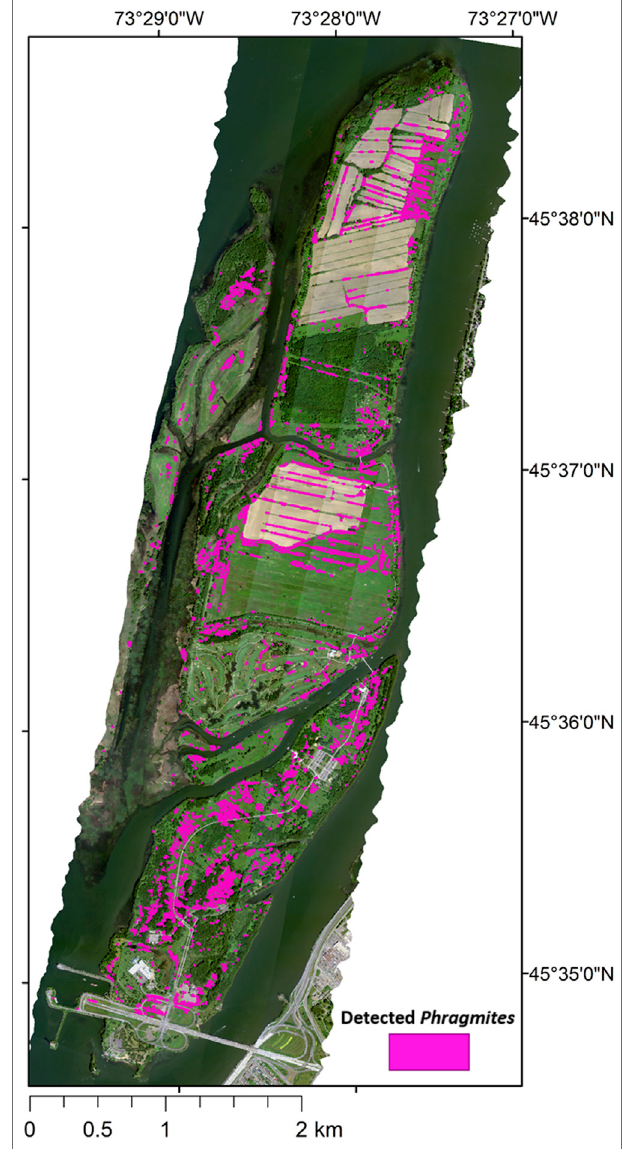
FIGURE 5 | The fi nal map of the extent of detected Phragmites within Îles-de-Boucherville National Park overlayed on the HSI mosaic.